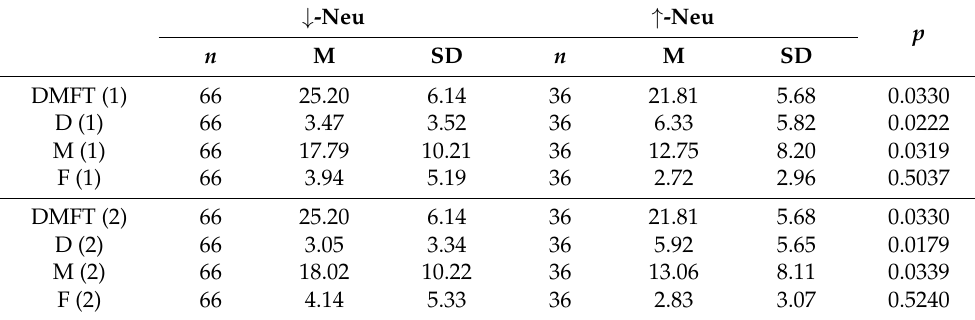
Table 4. Neutrophilic granulocytes count change and DMFT index before (1) and after (2) chemotherapy.